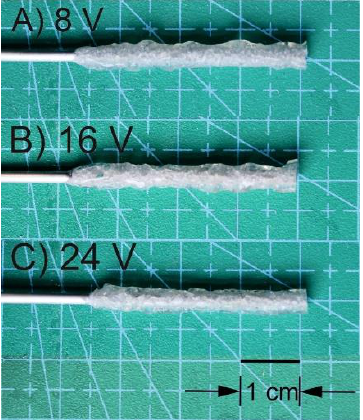
Figure 4. The photographs of deposits obtained from chitosan-hydroxyapatite colloidal solutions for the electrodeposition process initiated at voltages: ( A ) 8, ( B ) 16, and ( C ) 24 V.